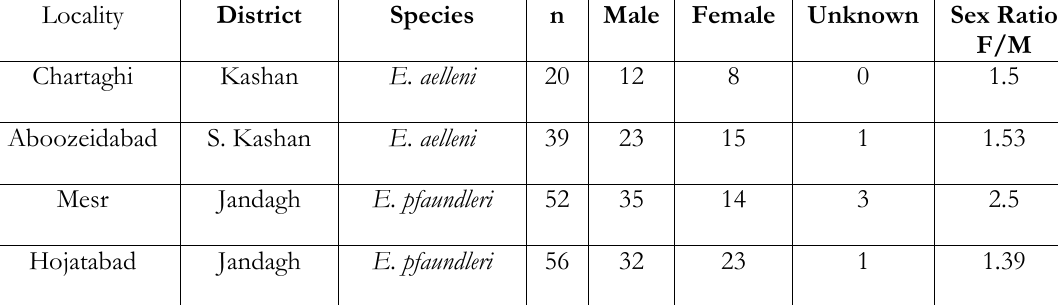
T ABLE 2. - Details of samples and origins of Eriodontes spp. From the Lute